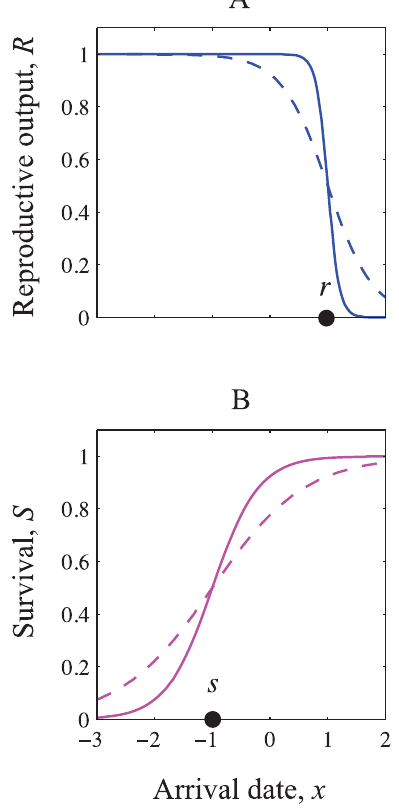
represents the maximal reproductive output. Shifts in the underlying food The parameter R 0